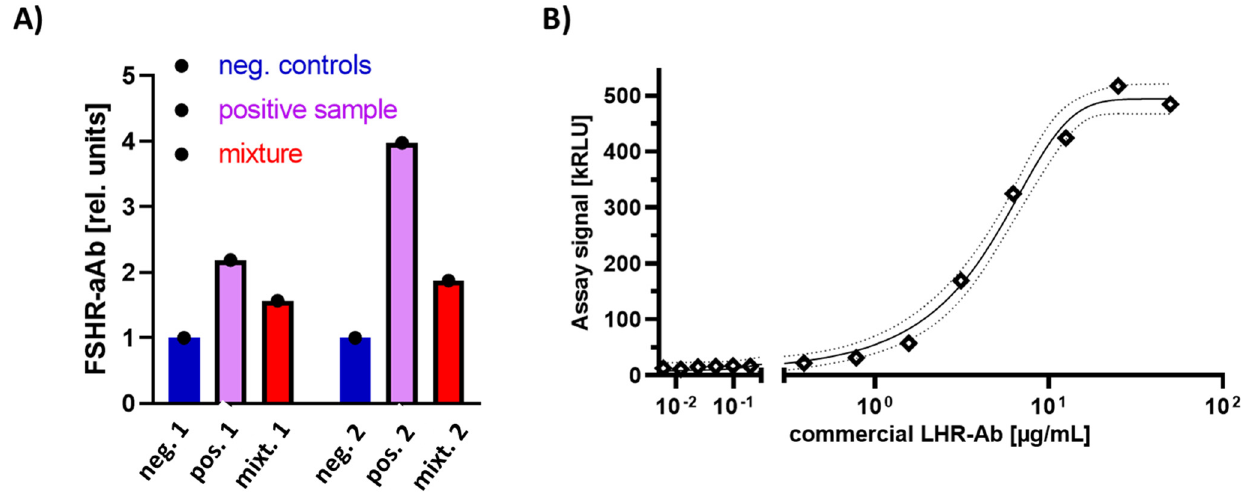
Figure 1. Performance test of the newly generated assays for quantifying autoantibodies to the FSHR and LHR. Recombinant full-length proteins of the human FSHR and LHR were expressed as fusion proteins with firefly luciferase in HEK293 cells and was used to detect and quantify receptor-binding antibodies. ( A ) Two samples positive for binding to the FSHR-luciferase fusion protein were identified in the serum samples analyzed; sample #1; slightly positive, and sample #2; highly positive. The positive samples were mixed (1:1, v / v ) with negative control serum. The assay signal of the mixture was close to the expected arithmetic mean of the positive and negative samples, indicating the absence of matrix effects. ( B ) A commercial antiserum to human LHR was identified and tested in linear dilution with the newly generated LHR-aAb assay. The signals increased with antibody concentrations and indicated a dynamic and sufficiently wide measurement range.